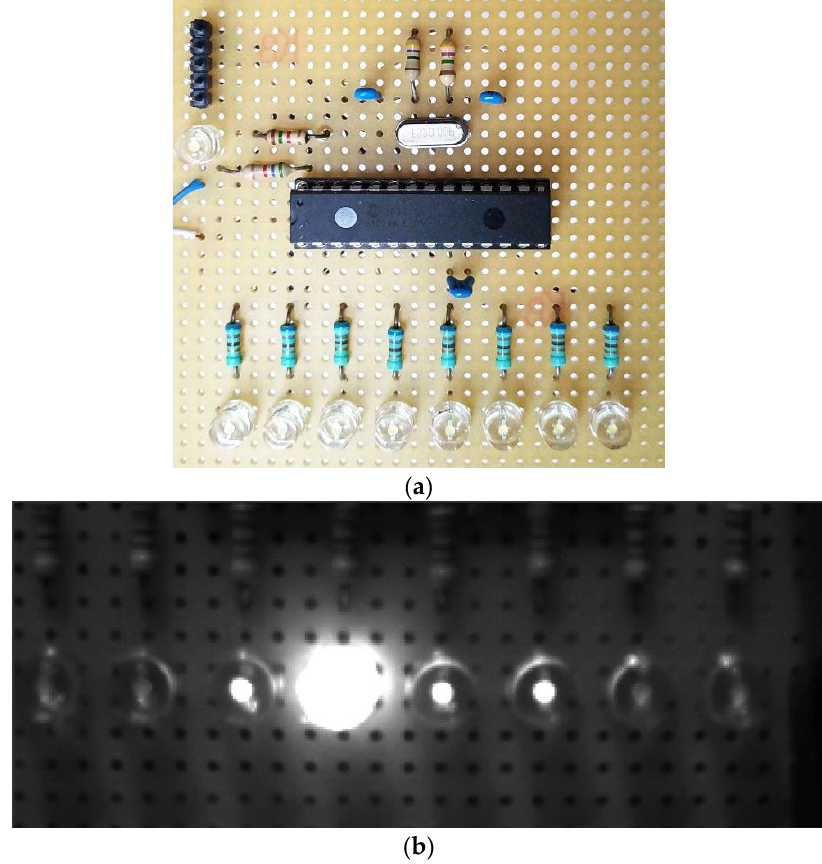
Figure 16. ( a ) LED array equipment. ( b ) Measurement of camera C3, with nominal 𝑇 𝑒𝑥𝑝 = 1/1000 and settings 𝑇 𝐶𝐸𝑁𝑇 = 1005 𝜇𝑠 , 𝑇 𝑆𝐼𝐷𝐸 = 1 𝜇𝑠 . and settings T = 1005 µ s, T = 1 µ CENT SIDE